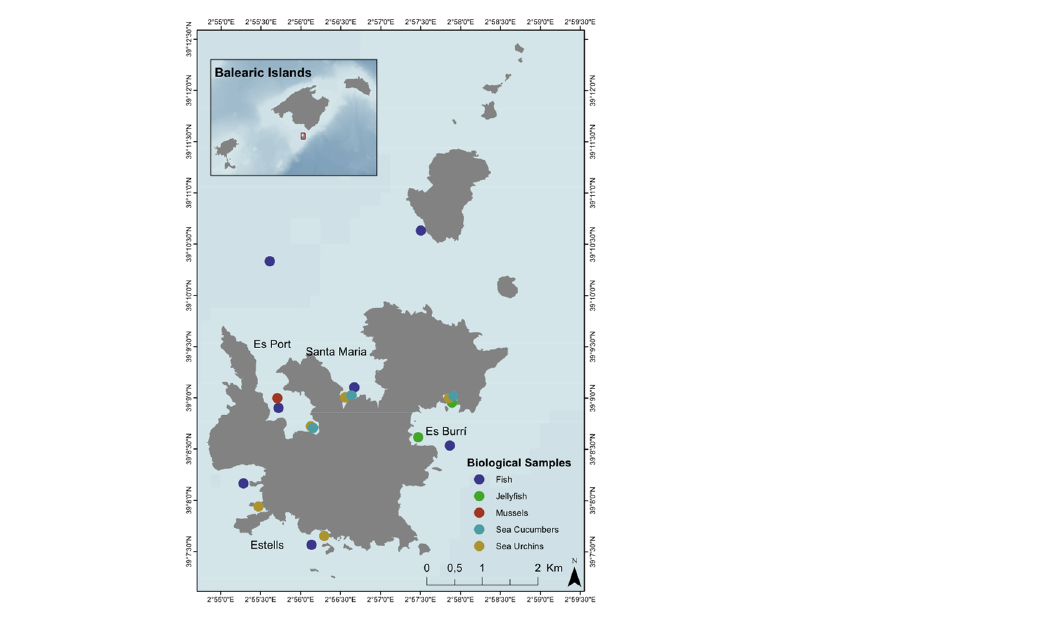
Figure 1. Study area and sampling sites for each of the species collected in the Cabrera National Park MPA located off the south-eastern coast of Mallorca in the Balearic Island Archipelago. The inset map indicates the location of the Cabrera National Park MPA with a red extent marker.